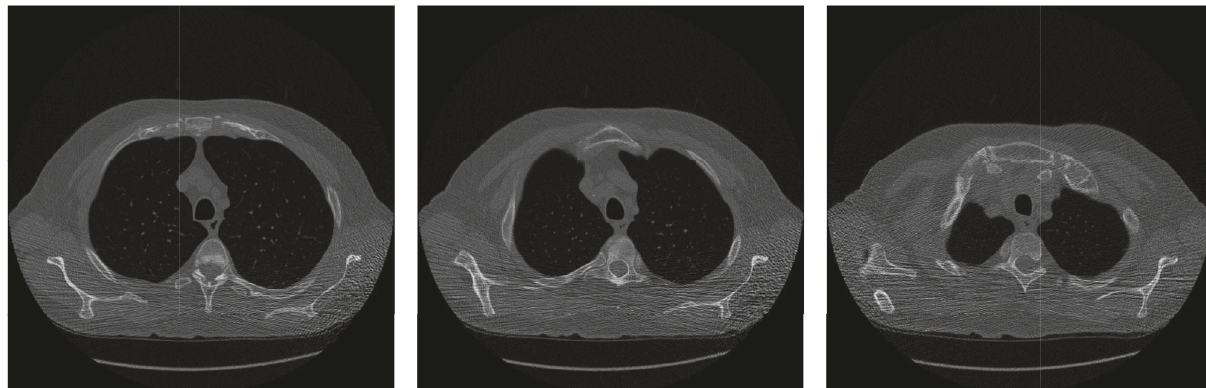
Figure 6: Demonstration of lung CT images (downloaded from [6]).